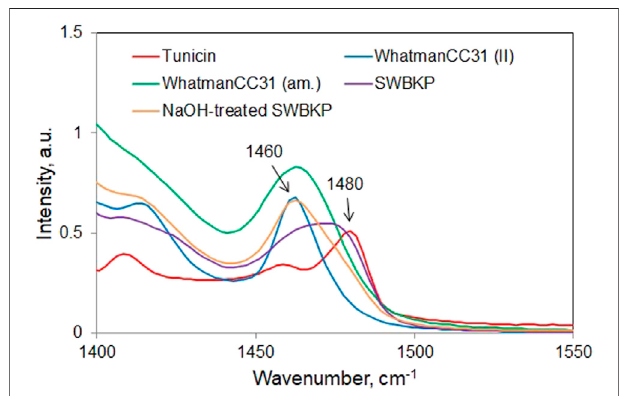
FIGURE2| Ramanspectraofselectedsamplesin1400-to1,550-cm − 1